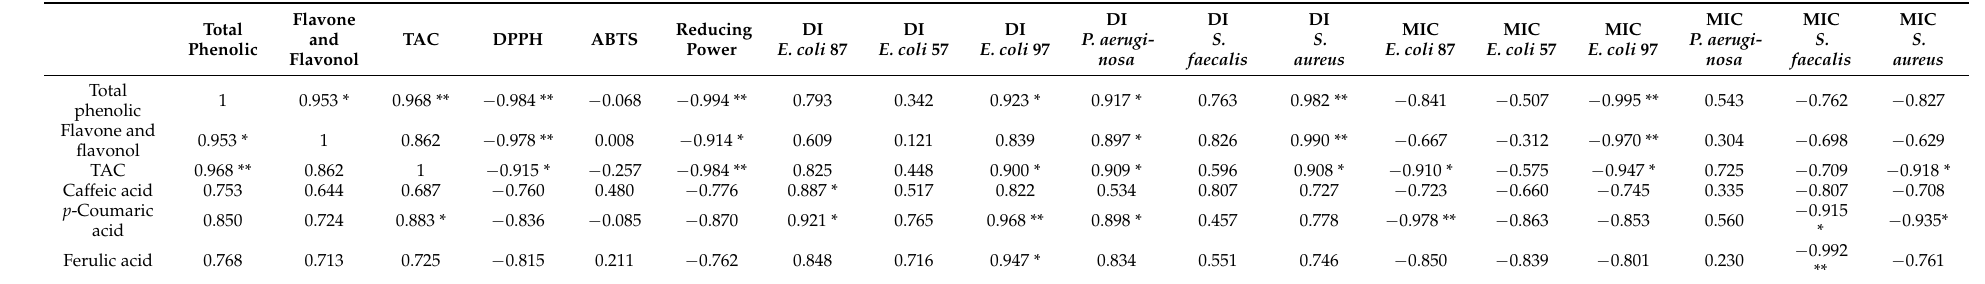
Table 7. Pearson correlation coefficients between the bioactive compounds and the assessed activities of propolis